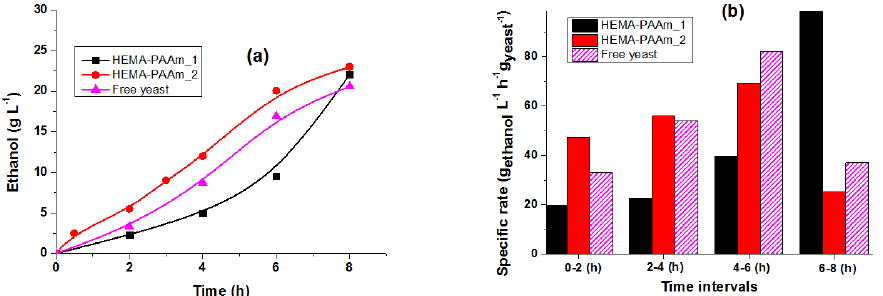
Figure 5. Fermentation of molasses solution with yeast immobilized on HEMA-PAAm and free yeast for ethanol production: (a) ethanol concentration in time; (b) specific rate of